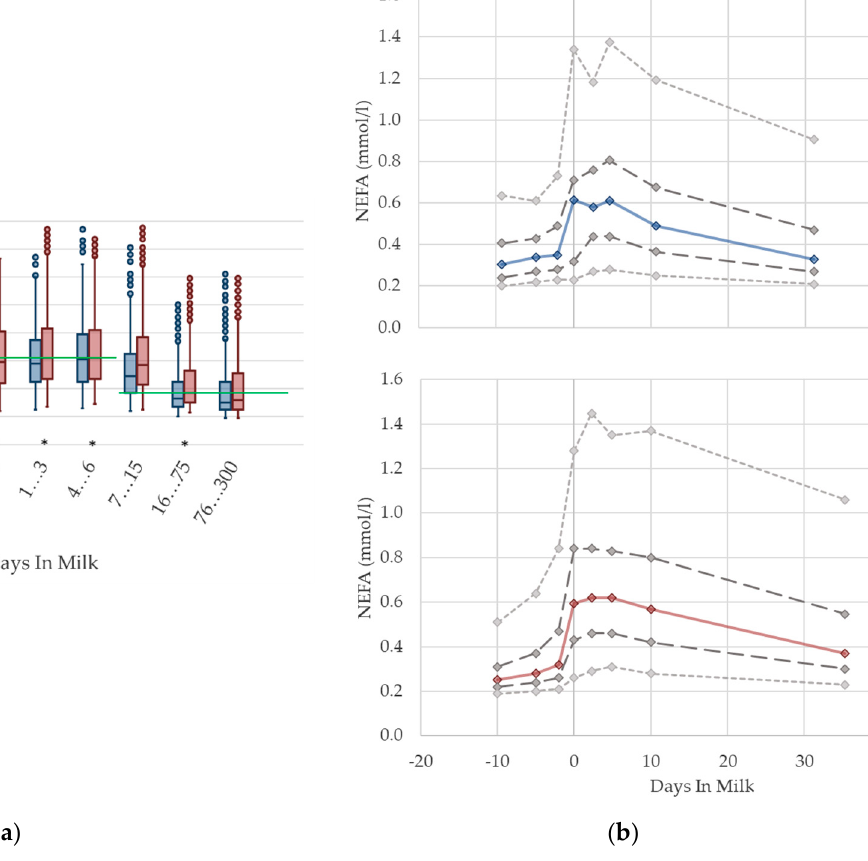
Figure 1. Serum concentrations of non-esterified fatty acids (NEFA) in primiparous (blue) and in multiparous (red) cows ( a ) in 10 classes between 30 days prepartum to 300 days postpartum (boxplots), green continuous lines represent the reference values according to Fürll [23], asterisk indicates significant differences regarding parity within DIM class; and ( b ) in 8 classes from 10 days prepartum to 40 days postpartum (median—continuous line; 1st and 3rd quartile—dashed lines; percentile 5 and 95—dotted lines).